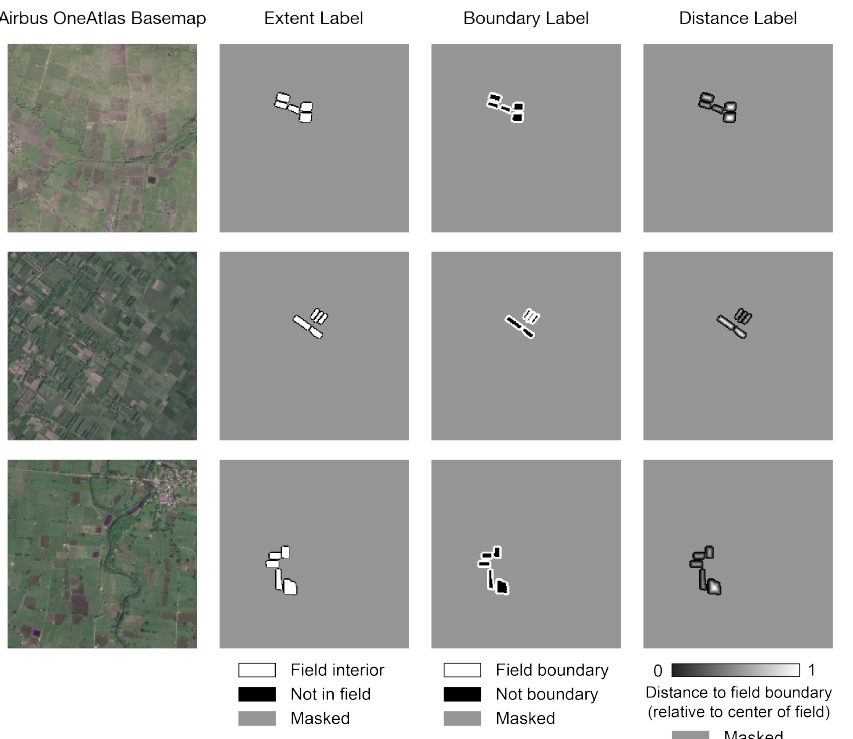
Figure A3. Examples of labels used for multi-task learning. Following the field delineation model design in Waldner et al. [31], we trained all neural networks in this paper to predict three tasks simultaneously: field extent, field boundary, and distance to field boundary. To train on partial labels, we mask out unlabeled pixels during training.